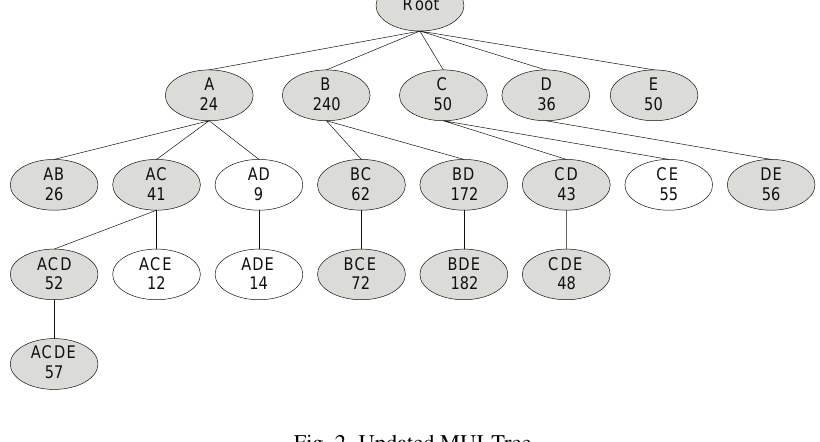
Fig. 2. Updated MUI-Tree